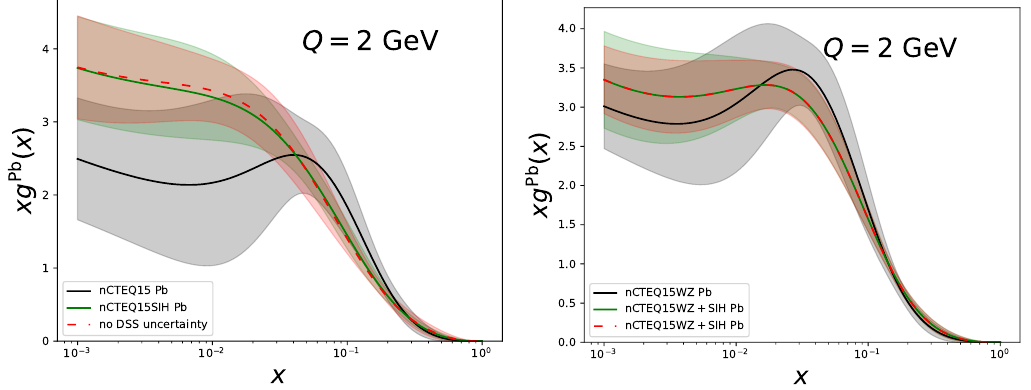
Figure 2: Gluon PDFs in lead. The baseline nCTEQ15 (left) / nCTEQ15WZ (right) is shown in black, the fit with unmodified data is shown in red, and the fit with added uncertainties from the DSS FFs is shown in green.